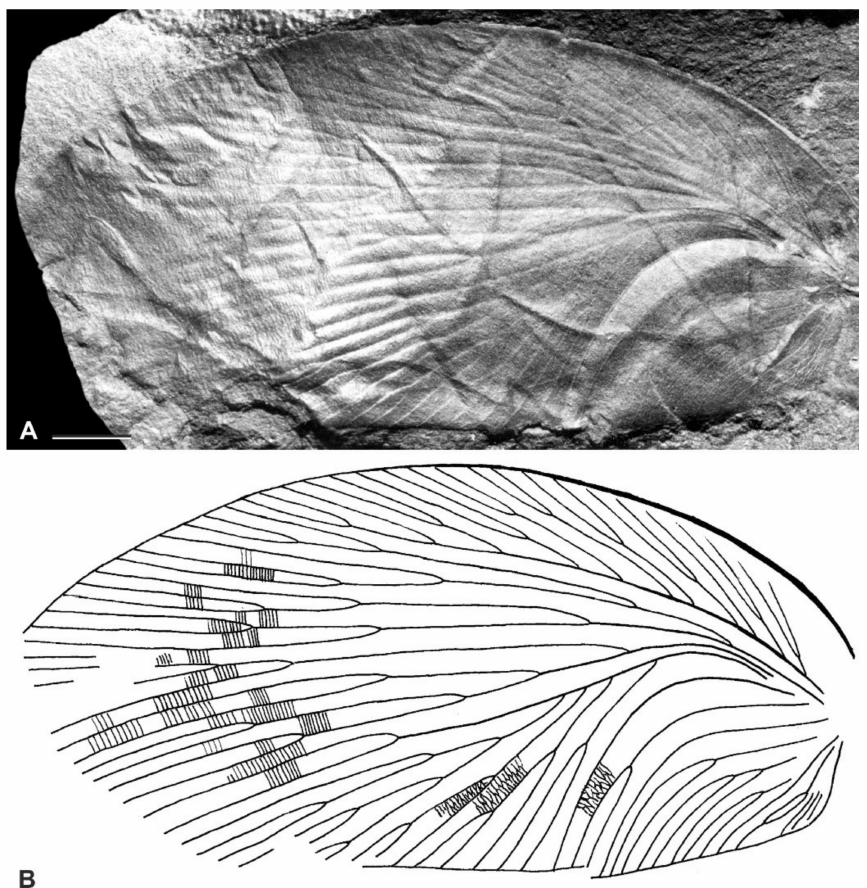
Figure 14. ( A , B )— Progonoblattina helvetica (Heer, 1864): type specimen of ‘ Dysmenes idoneus ’ Laurentiaux, 1966; Saint Jaques; reconstructed length 56 mm; scale bar 5 mm; photo: from Laurentiaux